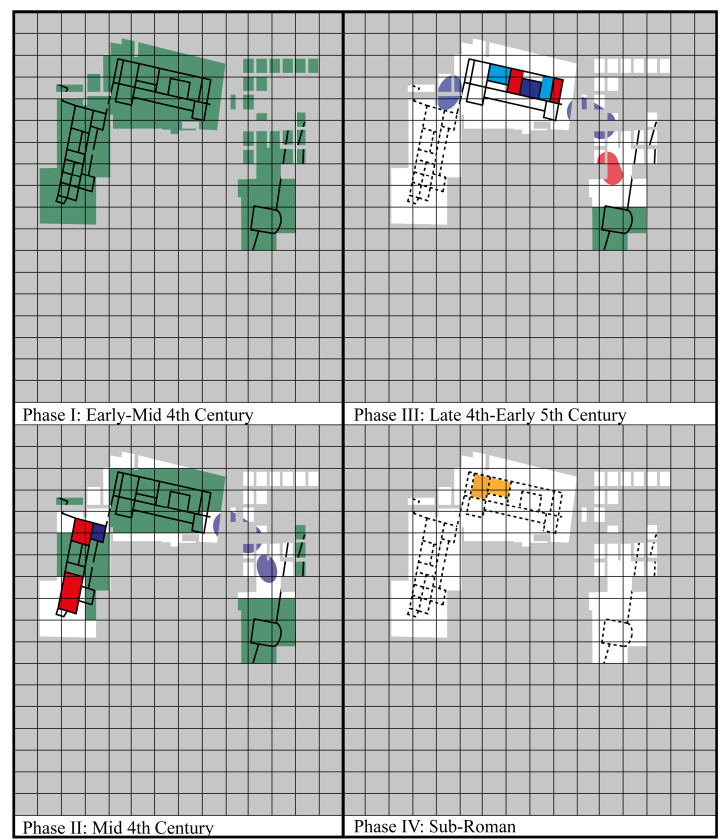
Figure 5: A high-resolution view of transformation at Beadlam, highlighting different types of transformational activity (red – habitational; dark blue – agricultural production; light blue – metalworking; yellow –